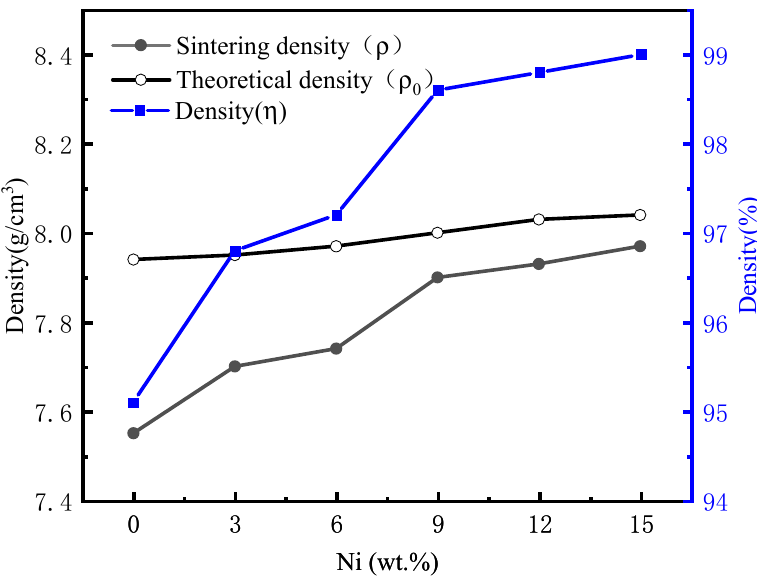
Figure 3. Density of the sintered matrix with different Ni contents.